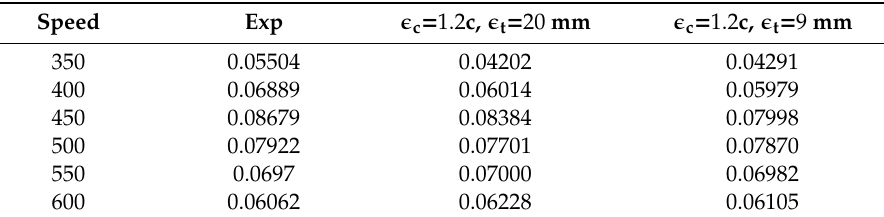
Table 2. Torque result when using different ϵ (cid:2930) value. (Unit: Nm)